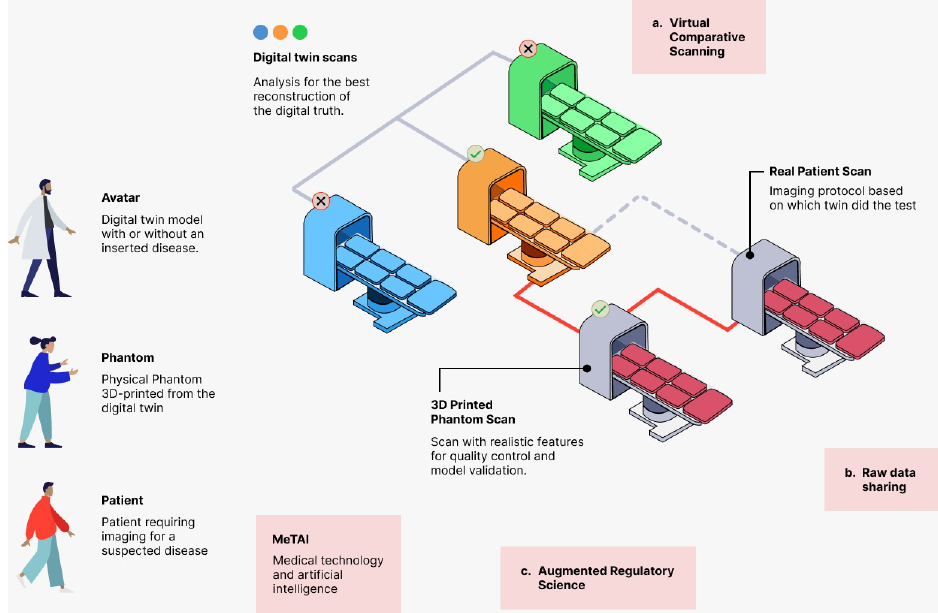
Figure 2. Metaverse in healthcare